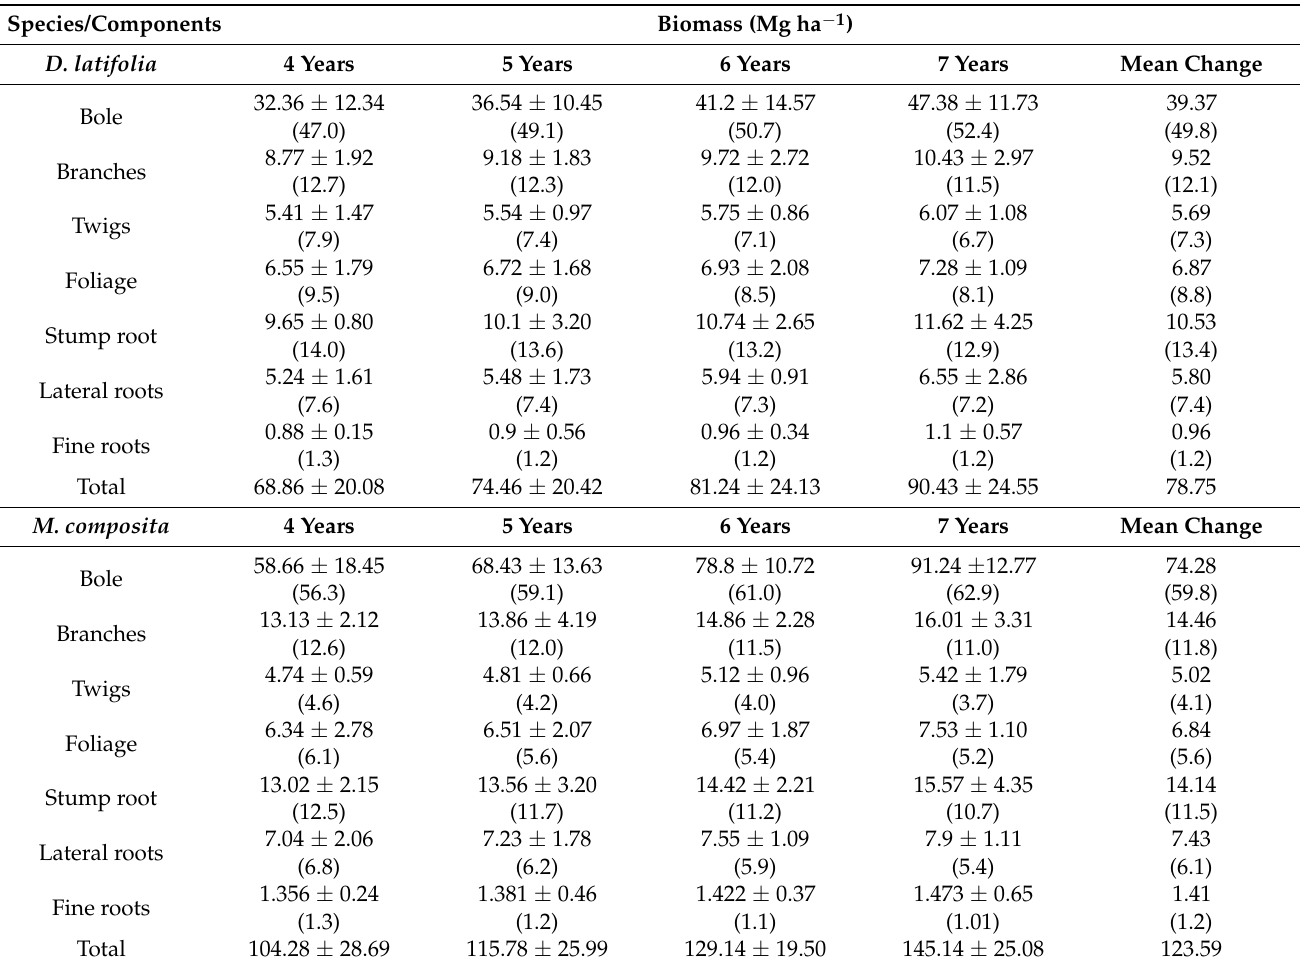
Table 3. Component-wise mean ± SE biomass (Mg ha − 1 ) of plantations. The values in parentheses indicate the percent distribution.